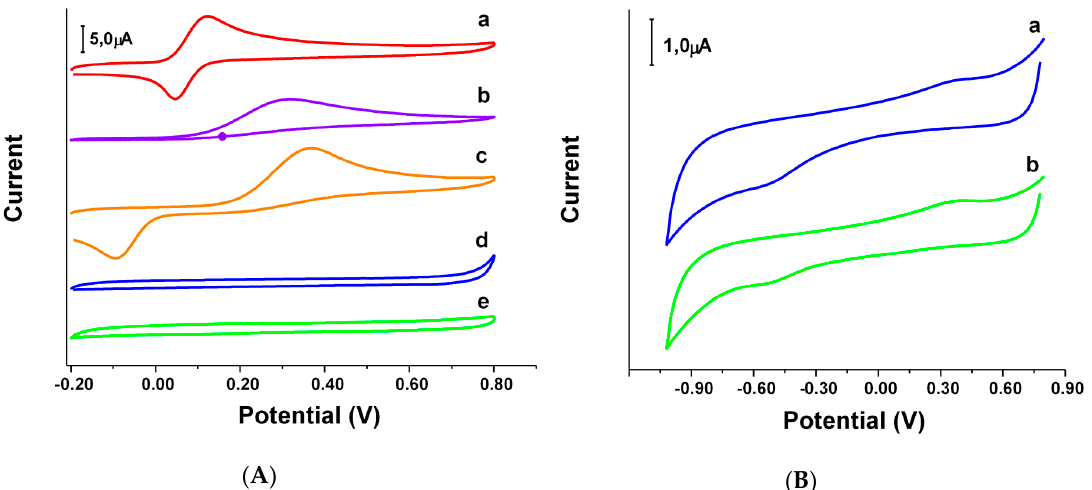
Figure 5. ( A ) Cyclic voltammograms for 5.0 × 10 − 4 M a) Tx, b) AAc, c) HQSAc, and 1.0 × 10 − 3 M d) oxazine 1 and e) oxazine 2 at a bare glassy carbon electrodes (GCE); ( B ) Cyclic voltammograms for 1.0 × 10 − 3 M a) oxazine 1 and b) oxazine 2 in a deoxygenated solution at a bare GCE. Supporting electrolyte: 0.050 M phosphate buffer solution pH 7.40. Scan rate: 0.100 V s − 1 .